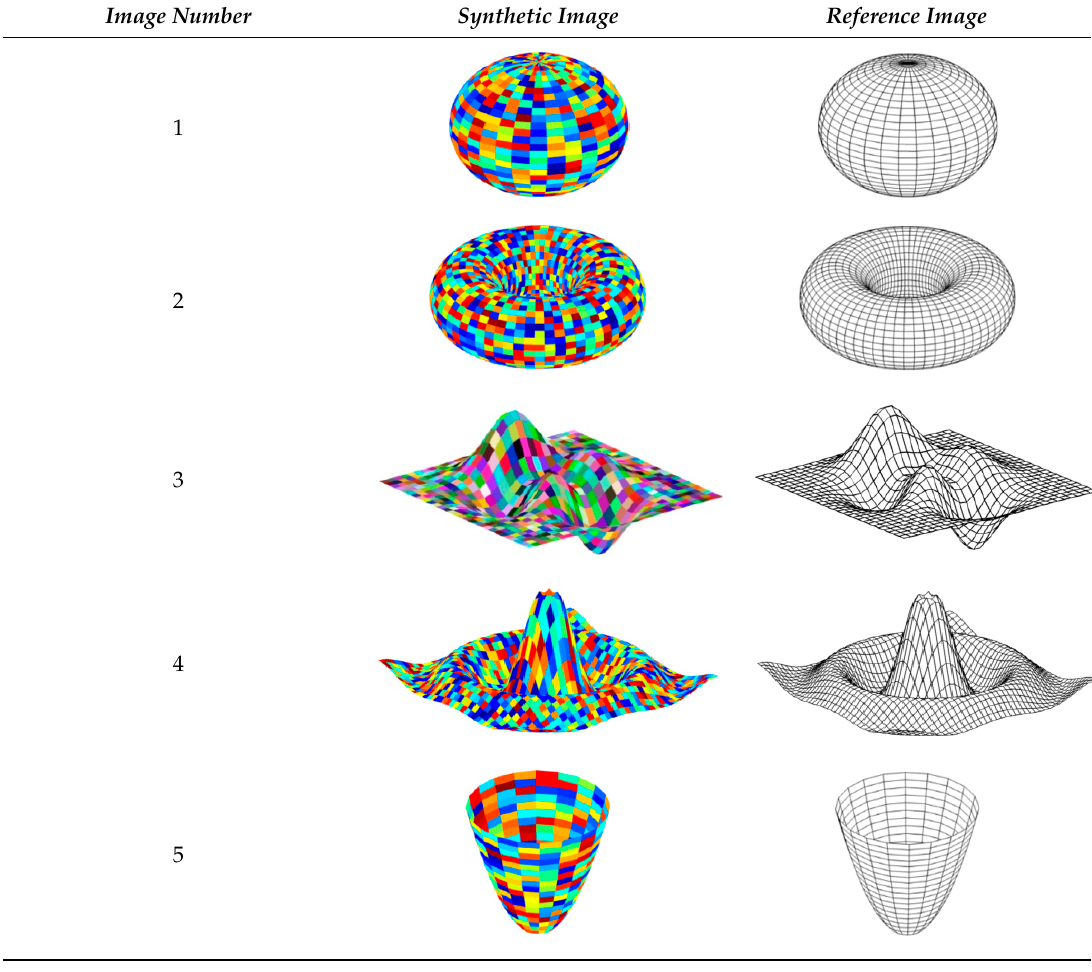
Table 7. Synthetic images database together with their reference images.